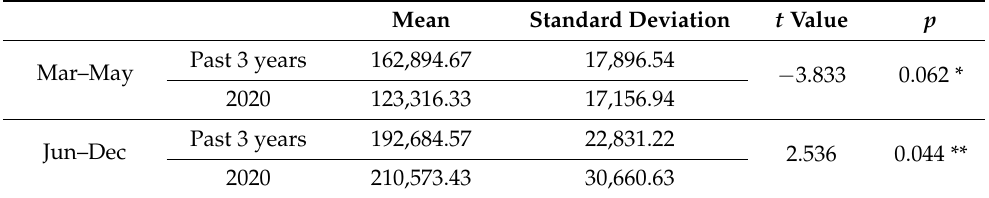
Table 4. Difference analysis of visitation numbers to Xitou Nature Education Area in recent